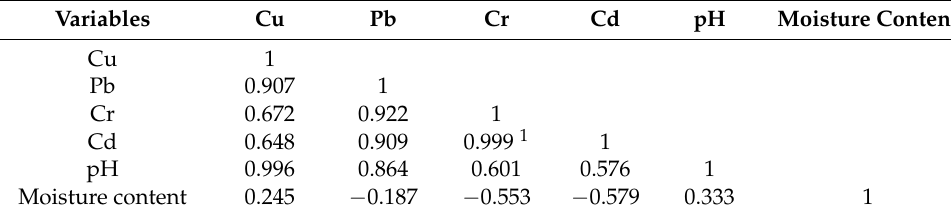
Table 3. Pearson’s correlation matrix for the HMs in the sediments from Port Bell, L. Victoria,